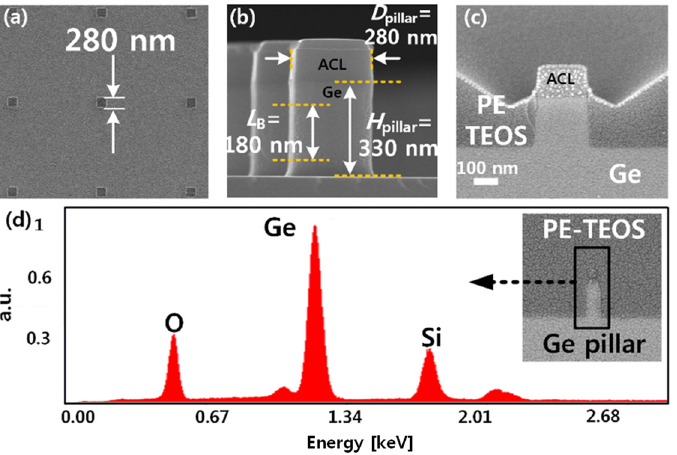
Figure 2. SEM images of the as-fabricated vertical Ge biristor and analysis data of the elementary components. ( a ) Top view SEM photograph. ( b ) Cross-sectional view SEM photograph. Diameter ( D pillar ), height ( H pillar ), and open-base length ( L B ) of the Ge pillar are 280 nm, 330 nm, and 180 nm, respectively. ( c ) Ge pillar after blanket etch-back of the PE-TEOS. ( d ) Energy dispersive spectroscopy (EDS) of the Ge pillar and PE-TEOS layer. The inset shows an SEM image of the deposited PE-TEOS on the Ge